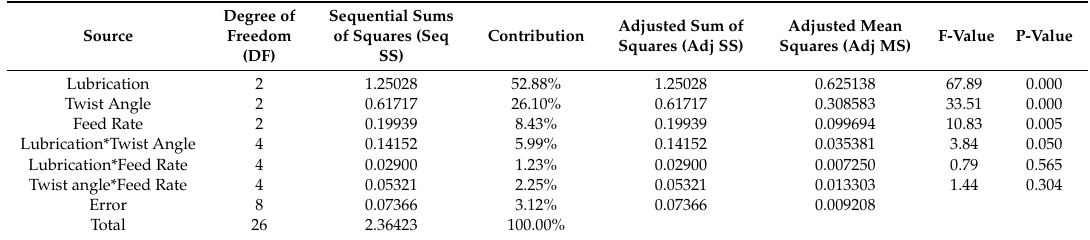
Table 9. Analysis of variance (ANOVA)